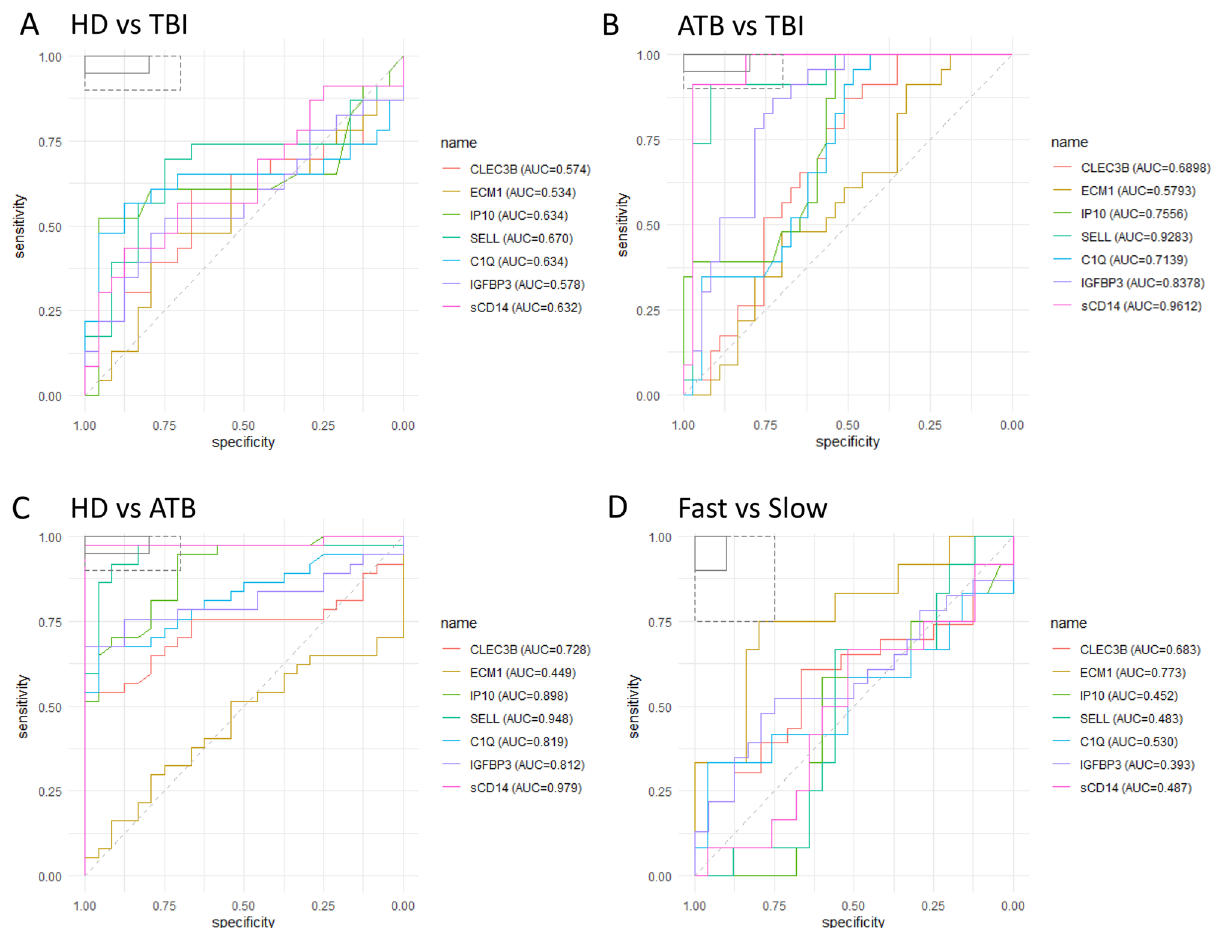
Figure 2. Receiver operating characteristic (ROC) curve analysis of biomarkers for triage and TB treatment. ROC curves for comparing the performance of different markers between healthy donors (HD) and TB infected (TBI) ( A ), active TB infection (ATB) vs. TBI ( B ), HD vs. ATB ( C ), and finally Fast and Slow treatment responders, are shown. In the top left box, the solid and dashed lines represent the respective optimal and minimum criteria set by the WHO in the target product profile (TPP) for a triage test for